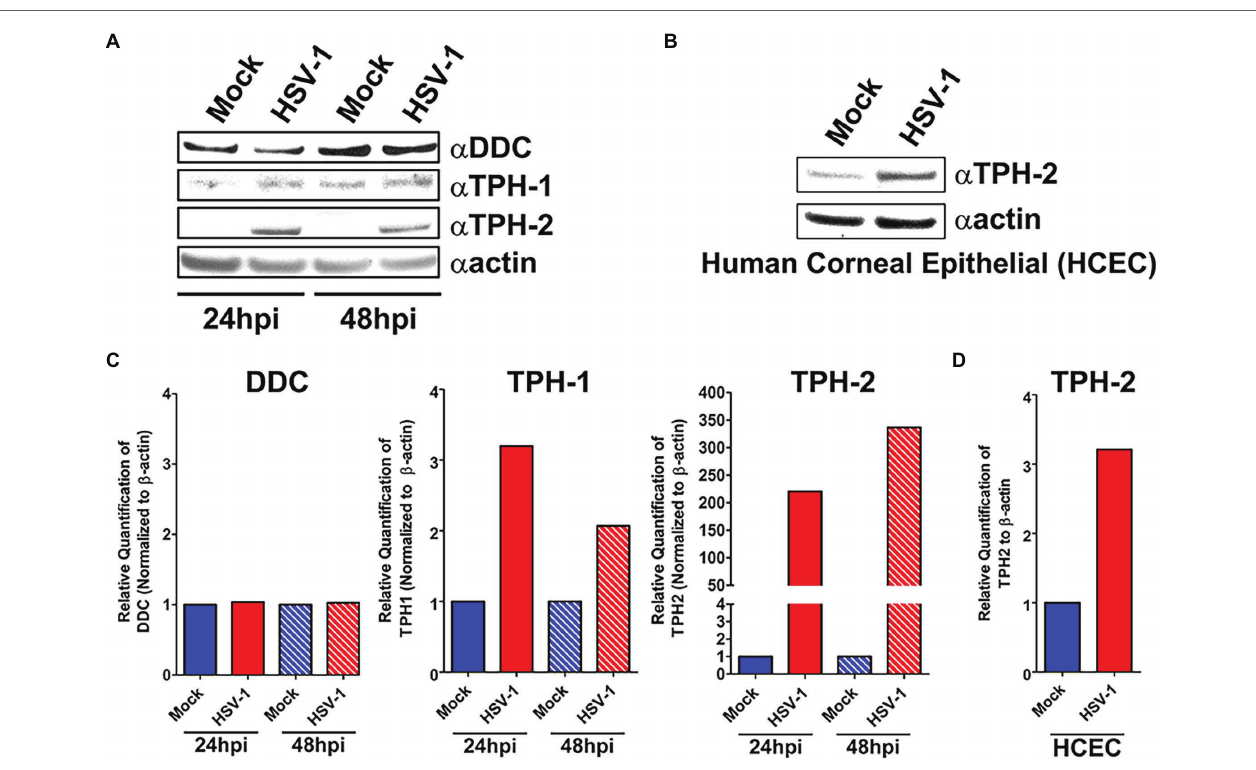
FIGURE 3 | Protein expression of key serotonin synthesis enzymes is upregulated following HSV-1 Infection. (A) Western blot analysis of DDC, TPH-1, and TPH-2 protein expression between HSV-1-infected and mock-infected A549 cell lysates at 24 and 48 hpi. (B) Quantification from A549 cell western blots of relative expression of DDC, TPH-1, and TPH-2 band intensity normalized to β -actin. (C) Western blot analysis of TPH-2 protein expression between HSV-1-infected and mock-infected HCEC at 24 hpi. (D) Quantification from HCEC western blots of relative expression of TPH-2 band intensity normalized to β -actin expressed in HCEC